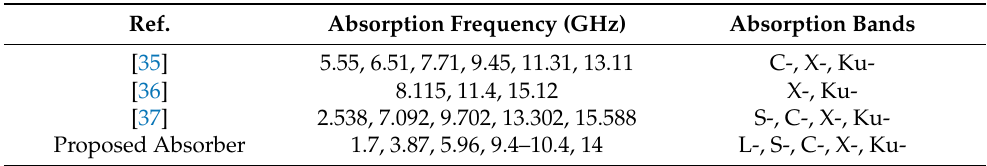
Table 1. A comparison of the absorption frequency and absorption bands of the proposed absorber with reported multifrequency absorbers.